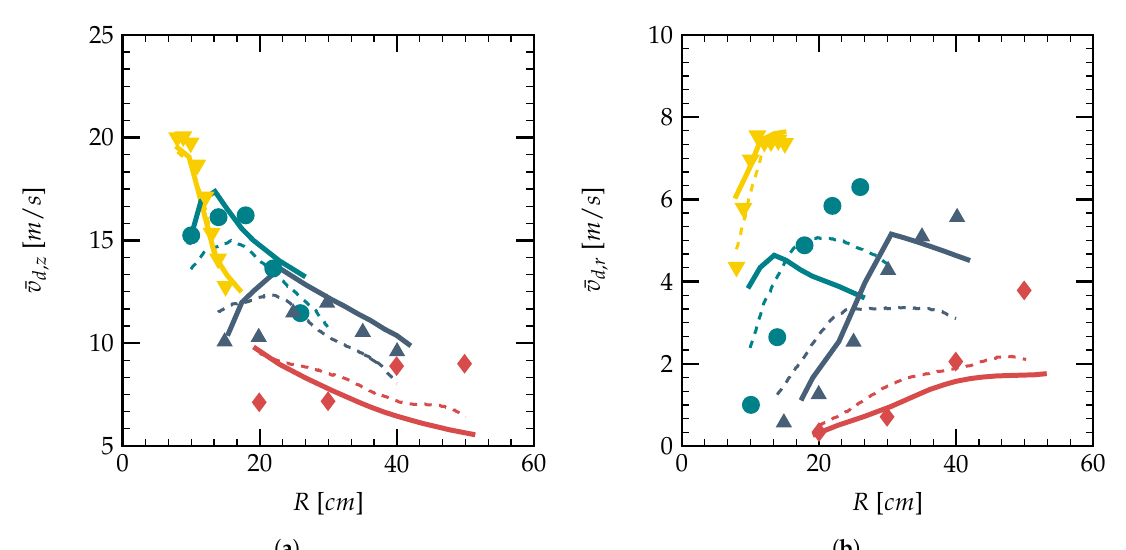
Figure 7. Validation of the droplet velocity at different vertical positions as a function of the radial distance from the center R for a polydisperse spray; ( a ) mean axial velocity ¯ v d , z and ( b ) mean radial velocity ¯ v d , r . Experimental measurements at h = 20 cm, ( ), h = 40 cm ( ), h = 60 cm ( ), h = 95 cm ( ); Numerical simulation of [21] at h = 20 cm